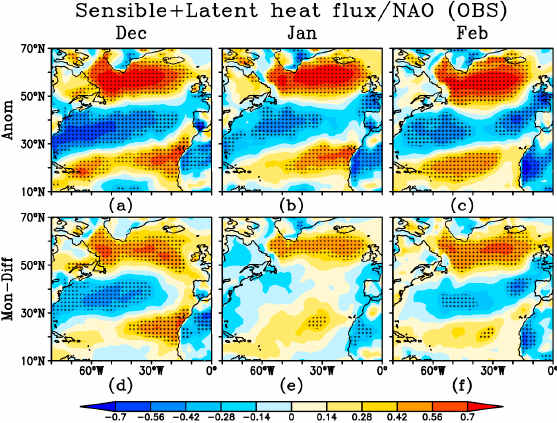
Figure 6. TCCs between the observed NAO and the monthly ( a – c ) and monthly difference of ( d – f ) heat fluxes (sum of sensible and latent heat flux) in December ( a , d ), January ( b , e ), and February ( c , f ). Dotted areas indicate statistical significance at the 95% confidence level, as estimated by a local Student’s t -test.